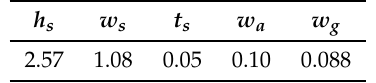
Table 1. Dimensions of the VSRR. Units are in